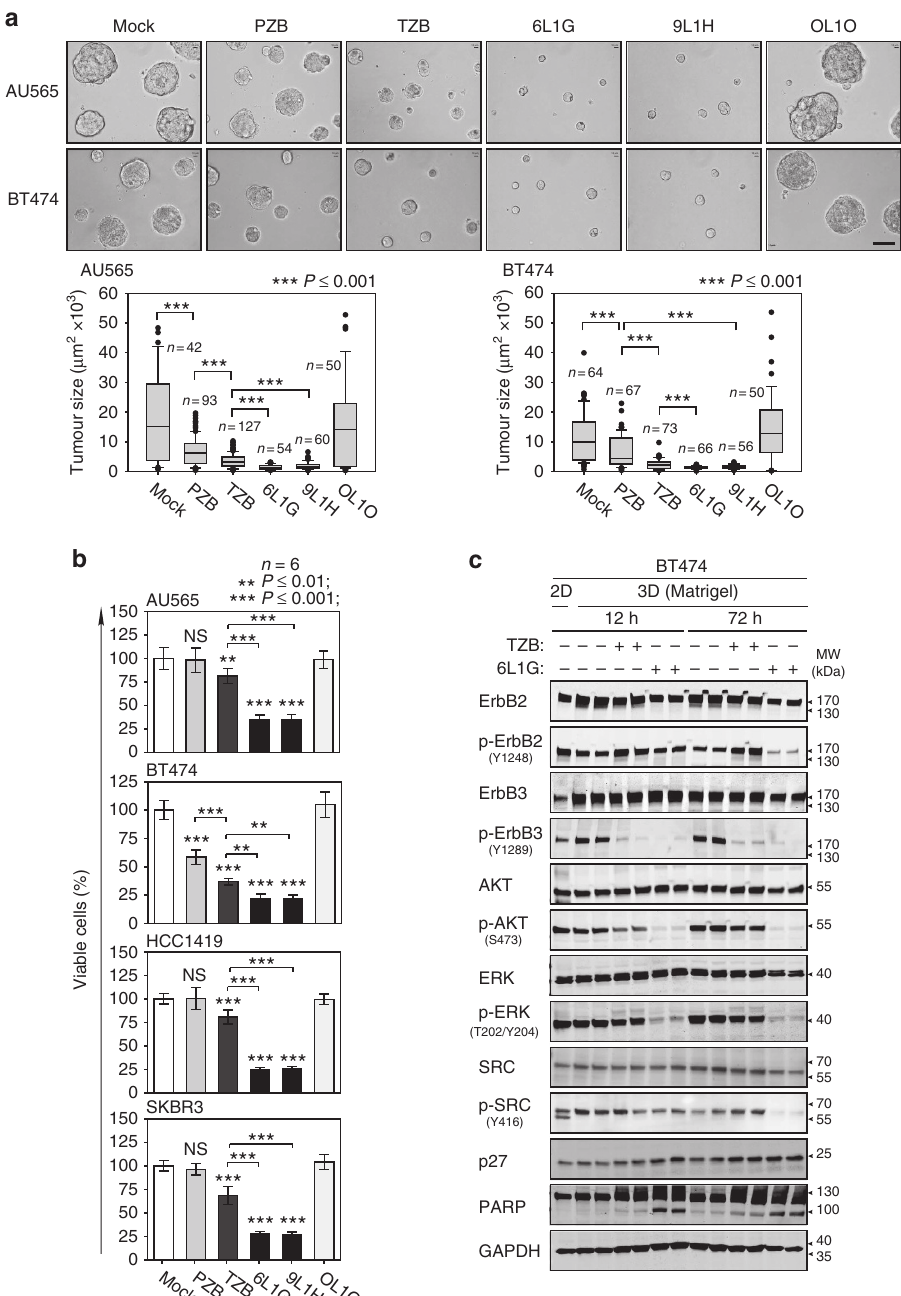
Figure 4 | Treatment efficacy in 3D tumour spheroid model. ( a ) 3D spheroid cultures of cancer cells grown on Matrigel. Top, micrographs showing AU565 and BT474 spheroids after 12 days with indicated treatment, for abbreviations see Fig. 2a. Bottom, size distribution of treated spheroids. Ten micrographs were analysed with Image J software (Mann–Whitney test). Scale bar, 50 m m. ( b ) Proliferation of treated 3D cultures of AU565, BT474, SKBR3 and HCC1419 in Matrigel were analysed by a modified XTTassay (* P value versus mock or as drawn, two-sided, unpaired Welch’s t -test). ( c ) AKT re-phosphorylation in 3D spheroids. BT474 cultures on Matrigel were treated by TZB or 6L1G and whole-cell extracts were analysed by 3,3 0 -dithiobis[sulfosuccinimidylpropionate] (DTSSP). Co-immuno-